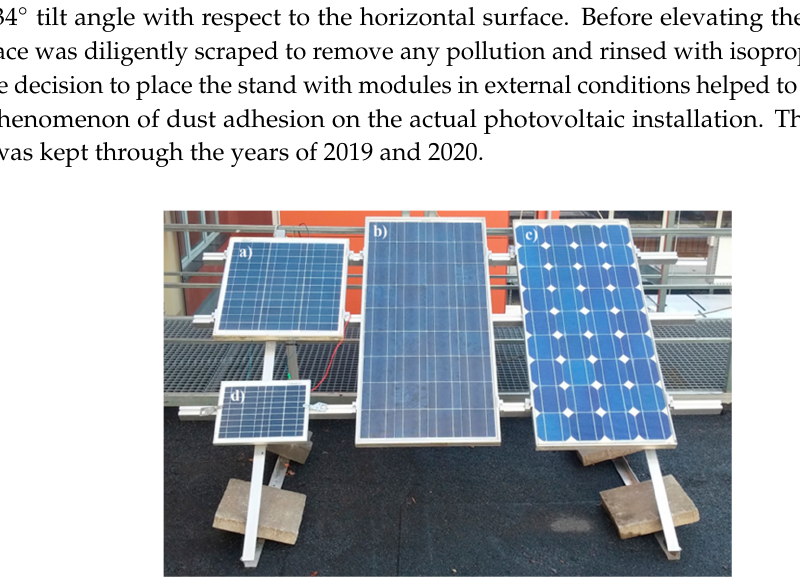
Figure 1. Photovoltaic modules chosen for the annual field study: ( a ) MWG-30, ( b ) AP-7105, ( c ) STP-085, ( d ) CLC010-12P.